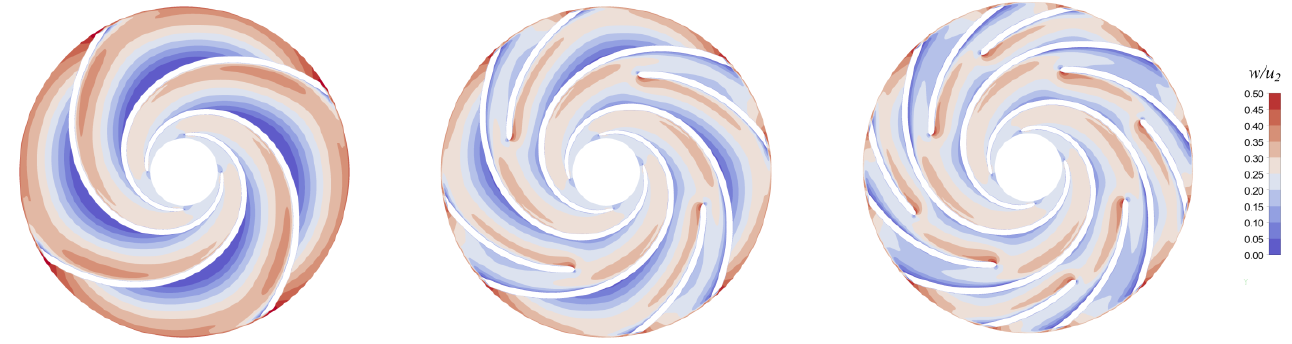
Figure 13. Relative velocity comparison at design point.